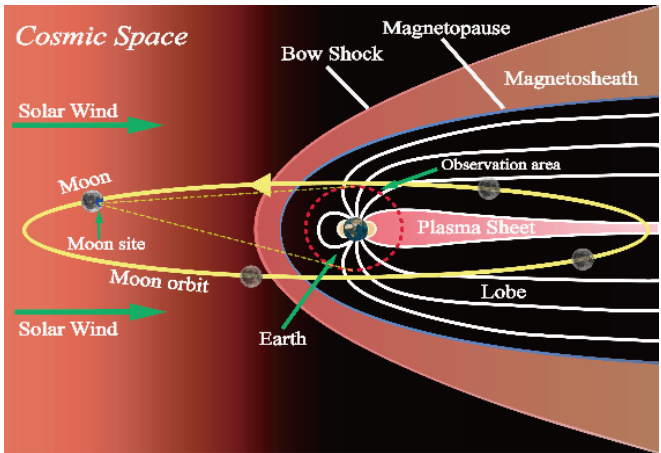
Figure 2. Other scientific TA except the whole Earth disc. During Moon’s nutation period, the mean Earth elevation of the near side in Figure 3 shows the uniform boundaries to cover different TAs. Lower elevations tend to cover smaller TAs. Taking the white dotted line of ‘3 Radius’ in Figure 3, for example, the areas inside the white dotted line might cover the whole TA with three times that of the Earth radius all the time, but the areas outside the white dotted line could only cover the whole TA at times. If the TA is about ‘40 Radius’, only the central part of near side can almost cover the whole. The elevation (orientation to Earth centroid) at a higher latitude is much smaller than that at a lower latitude. Different white dotted lines indicate the dividing lines of observation area with multiple Earth radii. The results in Figures 1a and 3 are not exactly the same, mainly because of time-varying elevations caused by complicated Earth–Moon motion, but it is still demonstrated that the dividing lines will be closer to the center of the near side when the TA’s radius becomes larger. Figure 3. The approximate dividing lines correspond to different TAs for average Earth centroid’s elevation distribution in the period of 18.6 years. However, for a specific MBSEO as shown in Figure 4, the topography has great in- fluence not only on FOV of TA, but also on occlusion of sunlight. The bigger the TA is, the more likely the obscured FOV caused by surrounding topography (e.g., hills, uplifts, and potholes) is to exist. A relatively flat area guarantees that there is a buffer area to satisfy the safety requirement of avoiding falling rocks from hills. Although the topography on the near side has smaller changes than other areas (e.g., the far side, the northern hemi- sphere, and southern hemisphere) mentioned in following section, it is still a factor to be